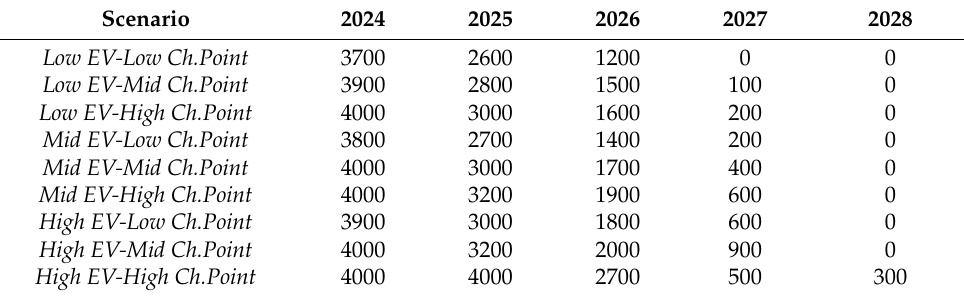
Table 10. Annual subsidy given to private agents per charging station in euros.